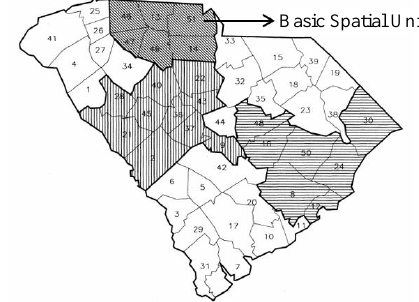
Figure 1. Spatial partitioning as aggregating or grouping of a large number of basic spatial units